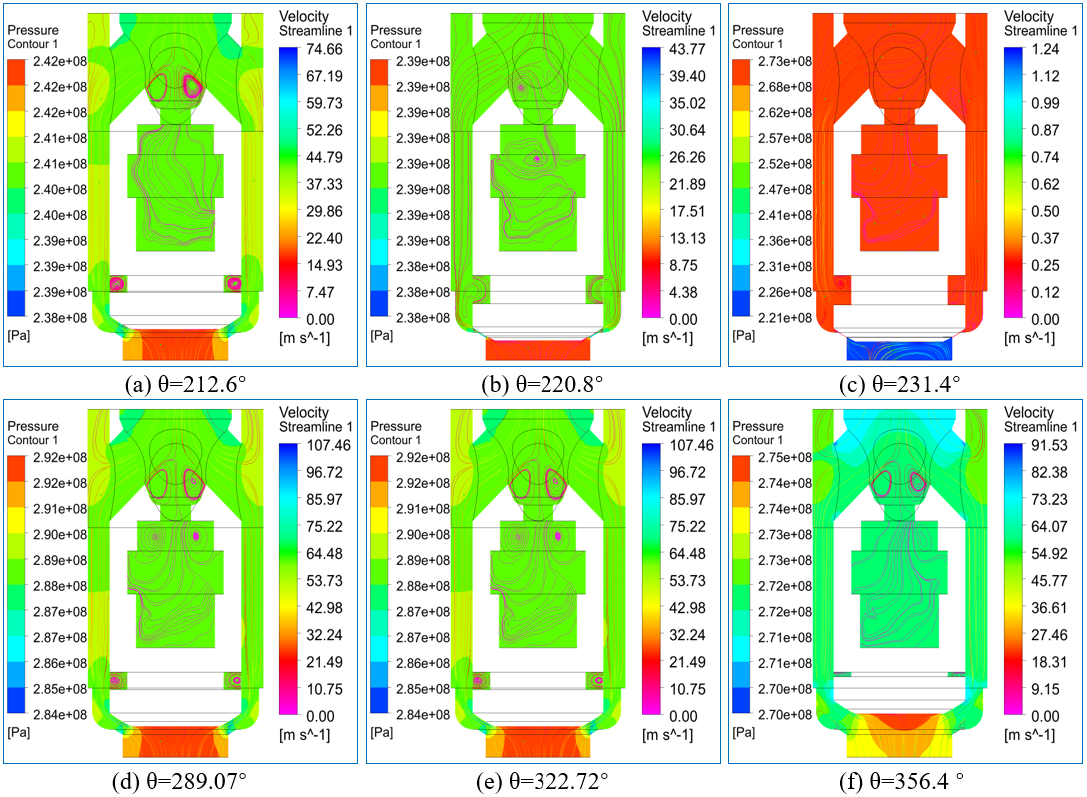
Figure 14. Pressure and velocity distribution during the opening process of the discharge